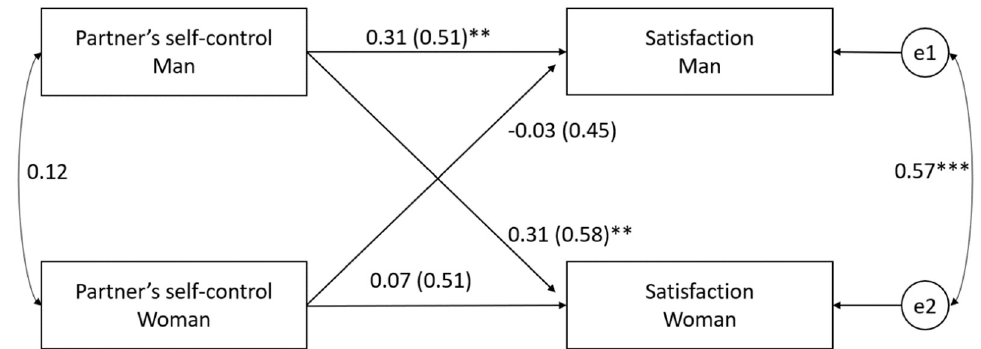
Figure 1. The partner’s perceived self-control and satisfaction with the relationship (Model 1). The independent and dependent variables are represented by rectangles; the two circles e1 and e2 present residual errors on satisfaction for males and females, respectively); the horizontal arrows describe the actor and diagonal arrows describe partner effects. The covariances between the independent variables are illustrated by curved double-headed arrows on the left; the curved double-headed arrow on the right represents the correlation between the two residuals; standardized coefficients are reported with standard error in parentheses. ** p < 0.01; *** p < 0.001. Table 3. Actor and partner effects of perceived partner’s self-control on relationship satisfaction.